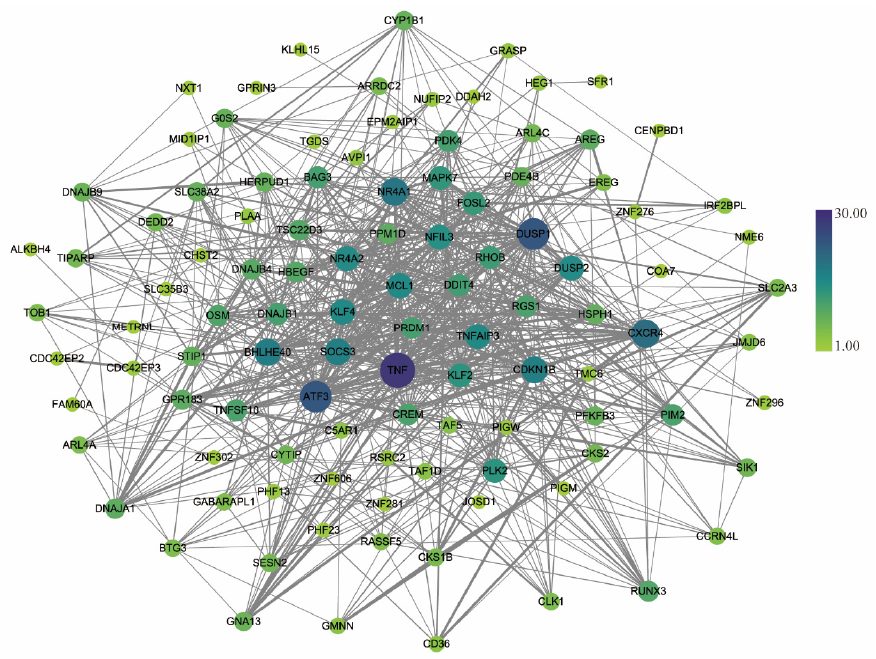
Figure 5. PPI network. Nodes represent genes, and edges represent the interaction of genes. The size of a node is positively correlated with the degree, and the edge between two nodes is positively correlated with the combined score.